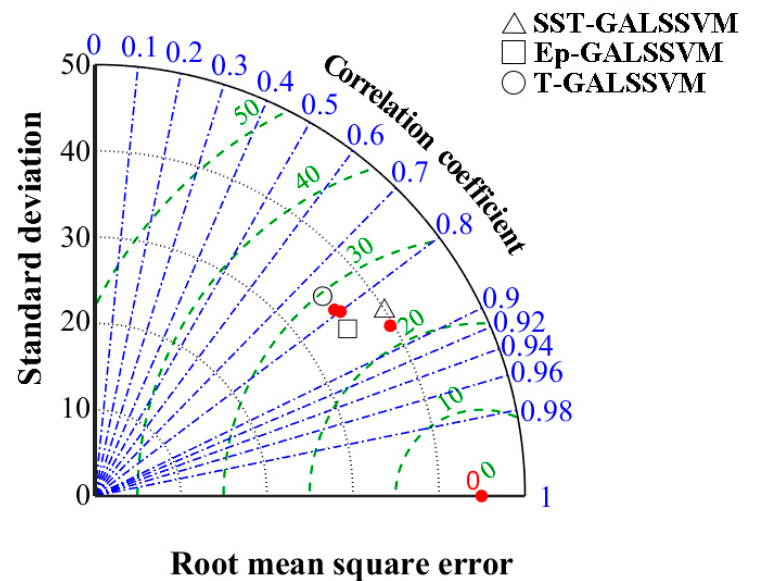
Figure 5. Taylor diagram of precipitation prediction integrating meteorological factors. The blue contours represent Pearson’s correlation coefficient; the green contours indicate RMSE; the black contours denote standard deviation of simulated diagram.